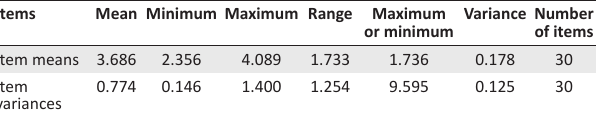
Variance Number or minimum of items